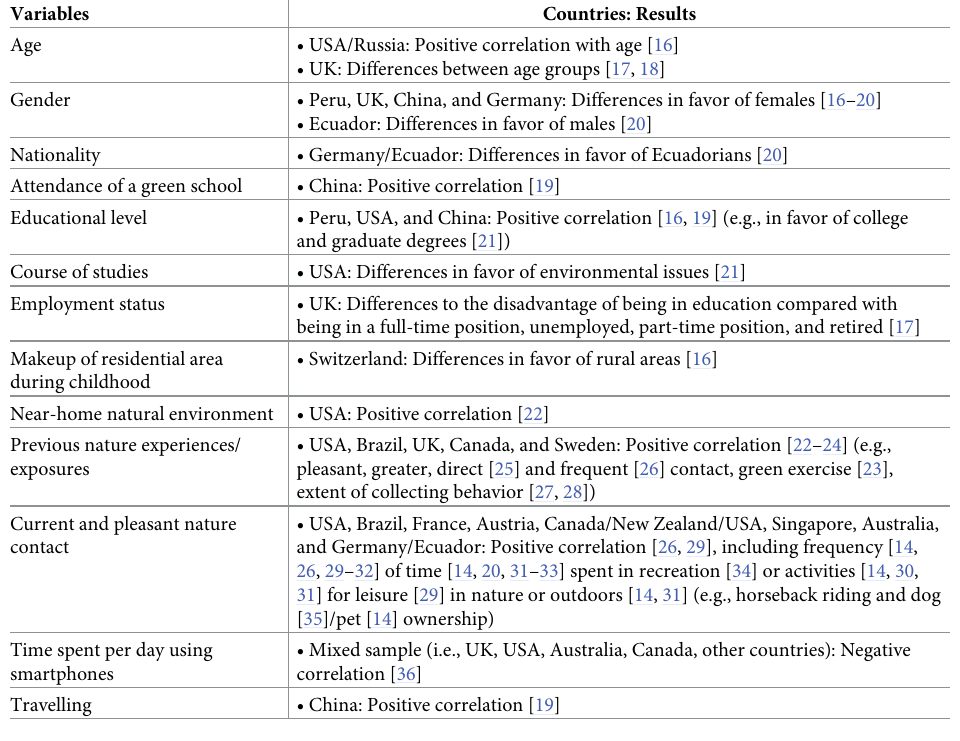
Table 1. Influencing factors of nature connectedness at the individual